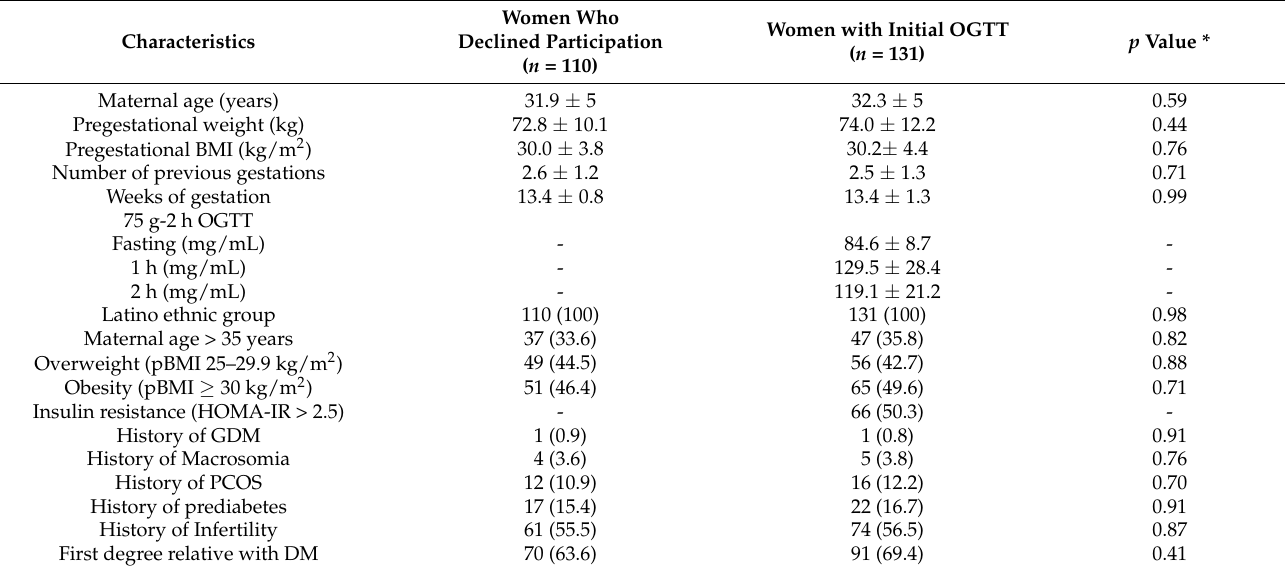
Table 1. Baseline characteristics and risk factors of eligible pregnant women who declined participa- tion versus women eligible with initial oral glucose tolerance test (OGTT).